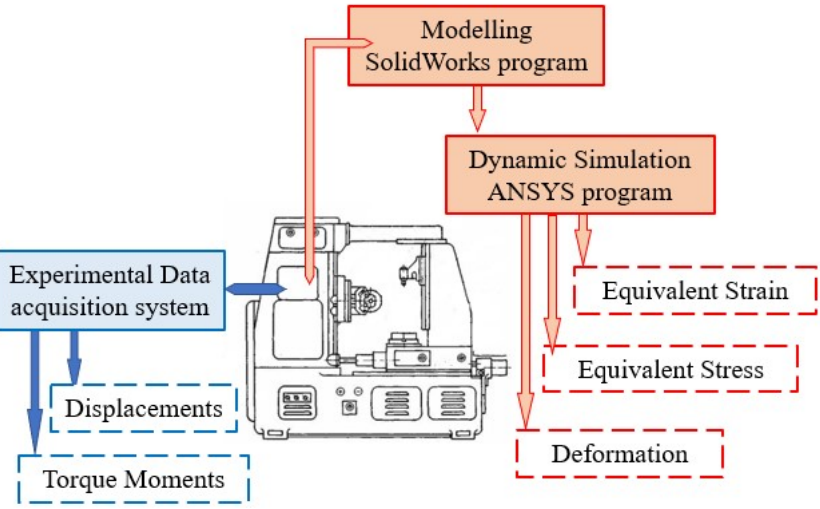
Figure 2. Diagram of experimental protocol.